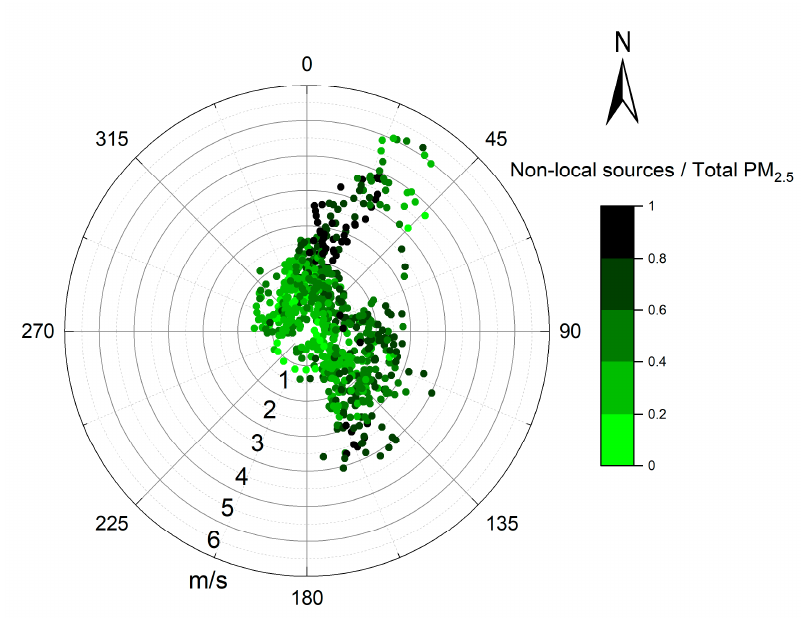
Figure 11. Ratio of non-local PM 2.5 to total PM 2.5 concentrations against wind speed and wind direction.